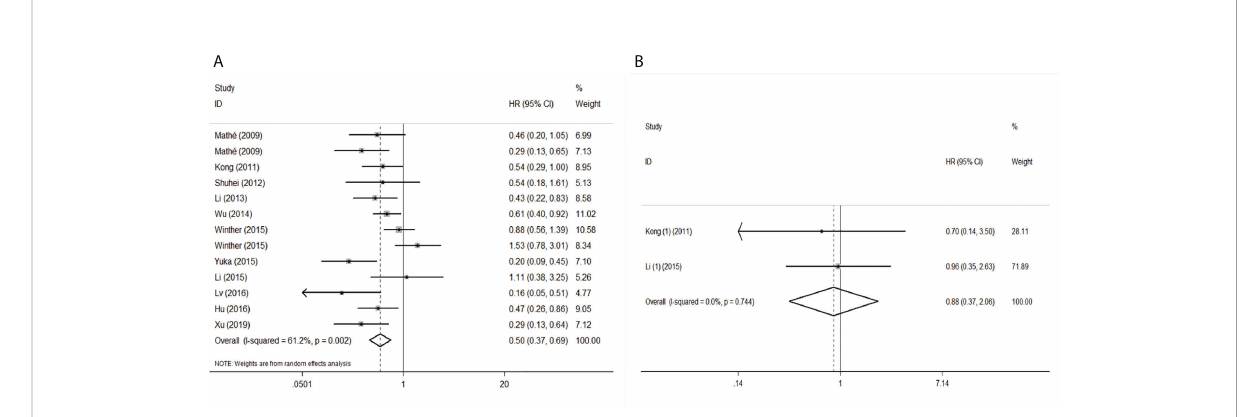
FIGURE 2 Forest plot of pooled HR of mir-375 in predicting survival outcomes in EC. (A) mir-375 and OS. (B) mir-375 and